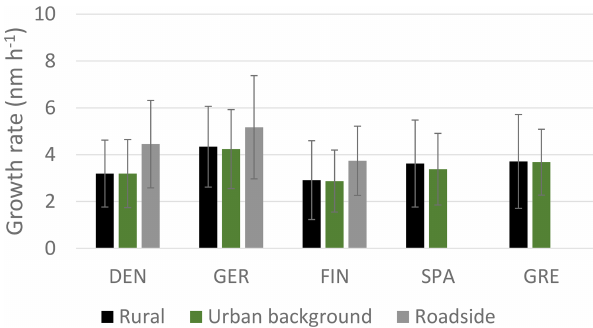
Figure 4. Growth rate of particles up to 30nm (with standard devi- ations) during new particle formation events at all sites.